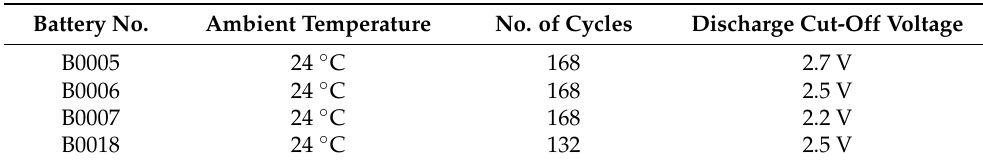
Table 1. Batteries selected for current work indicating the number of cycles, temperature, and cut-off voltages.